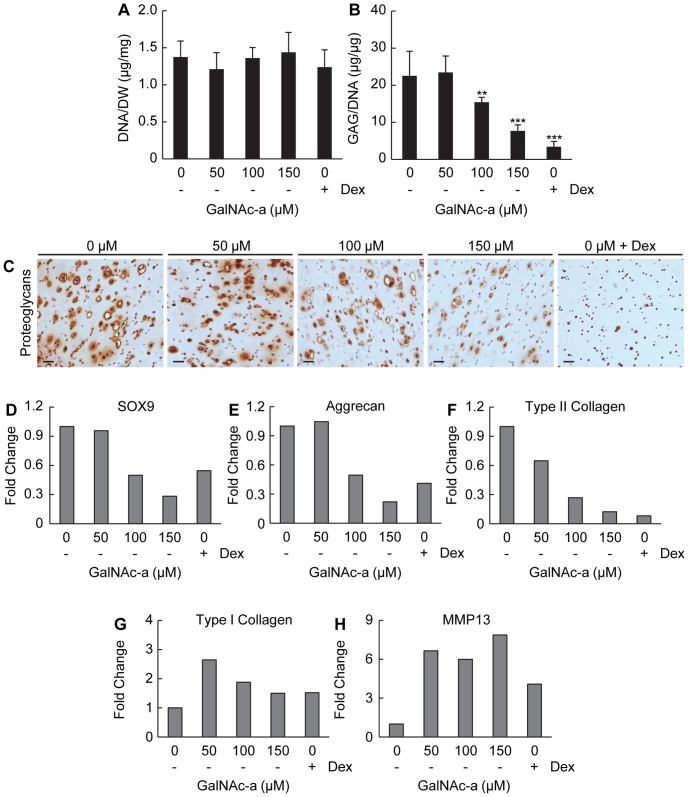
Biochemical and gene expression analysis of MSCs undergoing chondrogenesis (absence of ascorbic acid) in the presence of GalNAc-a or dexamethasone in 3D hydrogels.Quantification of biochemical composition of (A) DNA normalized to construct dry weight and (B) sGAG normalized to DNA content (n = 4, **P<0.01, *** P<0.001 versus no analog exposure). (C) Histological staining for proteoglycans using Safranin-O (scale bar: 50 µm). Gene expression analysis of markers for (D-G) chondrogenesis and matrix production with (H) MMP13 were evaluated (presented as described in Figure Legend 6).